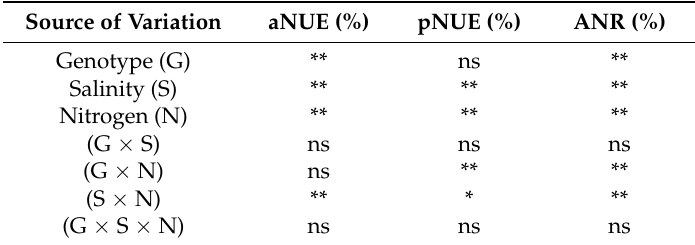
Table 9. Summary of analysis of variance for agronomic nitrogen use efficiency (aNUE), physiological nitrogen efficiency (pNUE), and apparent nitrogen recovery (ANR) in a controlled greenhouse study. aNUE (%)